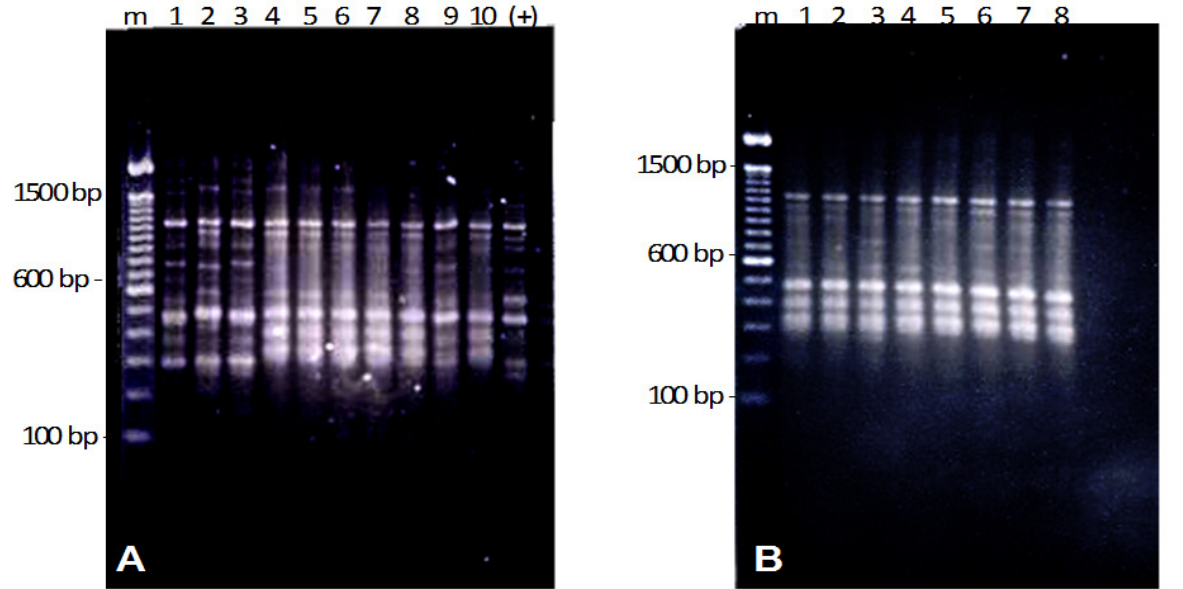
Figure 3. Spread of clone H4 among patients from the neonatal intensive care unit (high risk nursery). ( A ) Lanes 1 to 3: N-EAV (clones N1, N2 and N3). All others: clone N4 (lane 4: N-EAS; lane 5: N-KC; lanes 6 to 8: N-MAS; lanes 9-10: N-MCS). ( B ) All isolates belong to the clone N4 (lane 1: N-MCS; lane 2: N-MGAV; lanes 3-8: N-MC). +: positive control; m: molecular weight